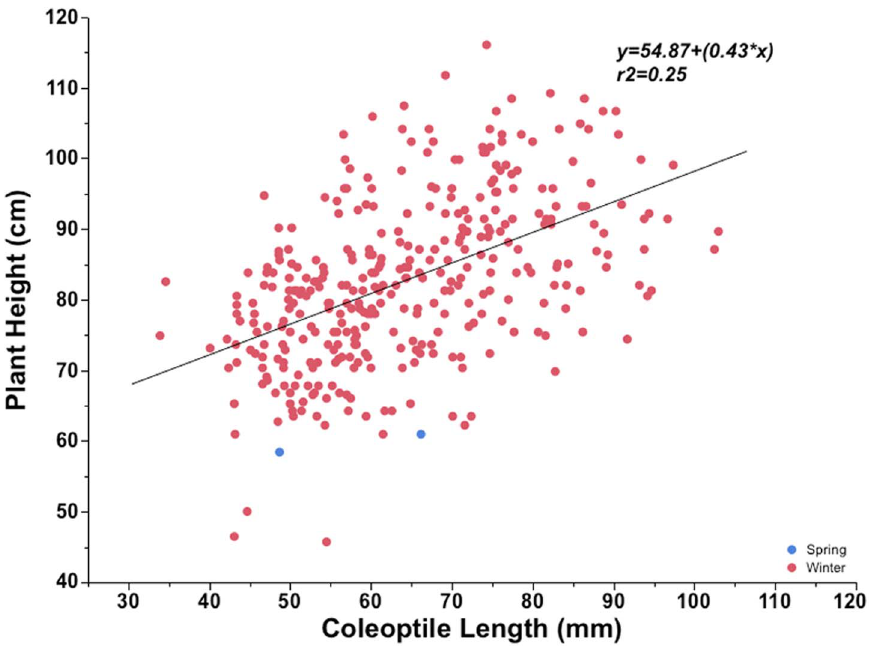
Figure 6. Mean plant height at maturity of spring and winter type cultivars in the world wheat collection entries plotted against coleoptile length.